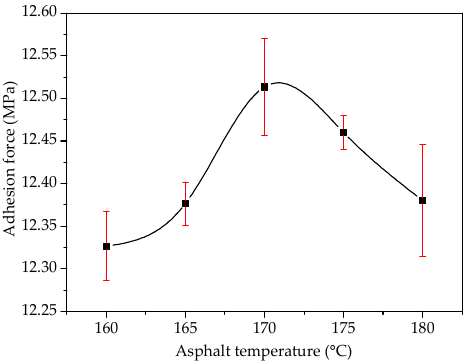
Figure 3. Effect of asphalt temperature on the adhesion at the asphalt–steel slag interface.